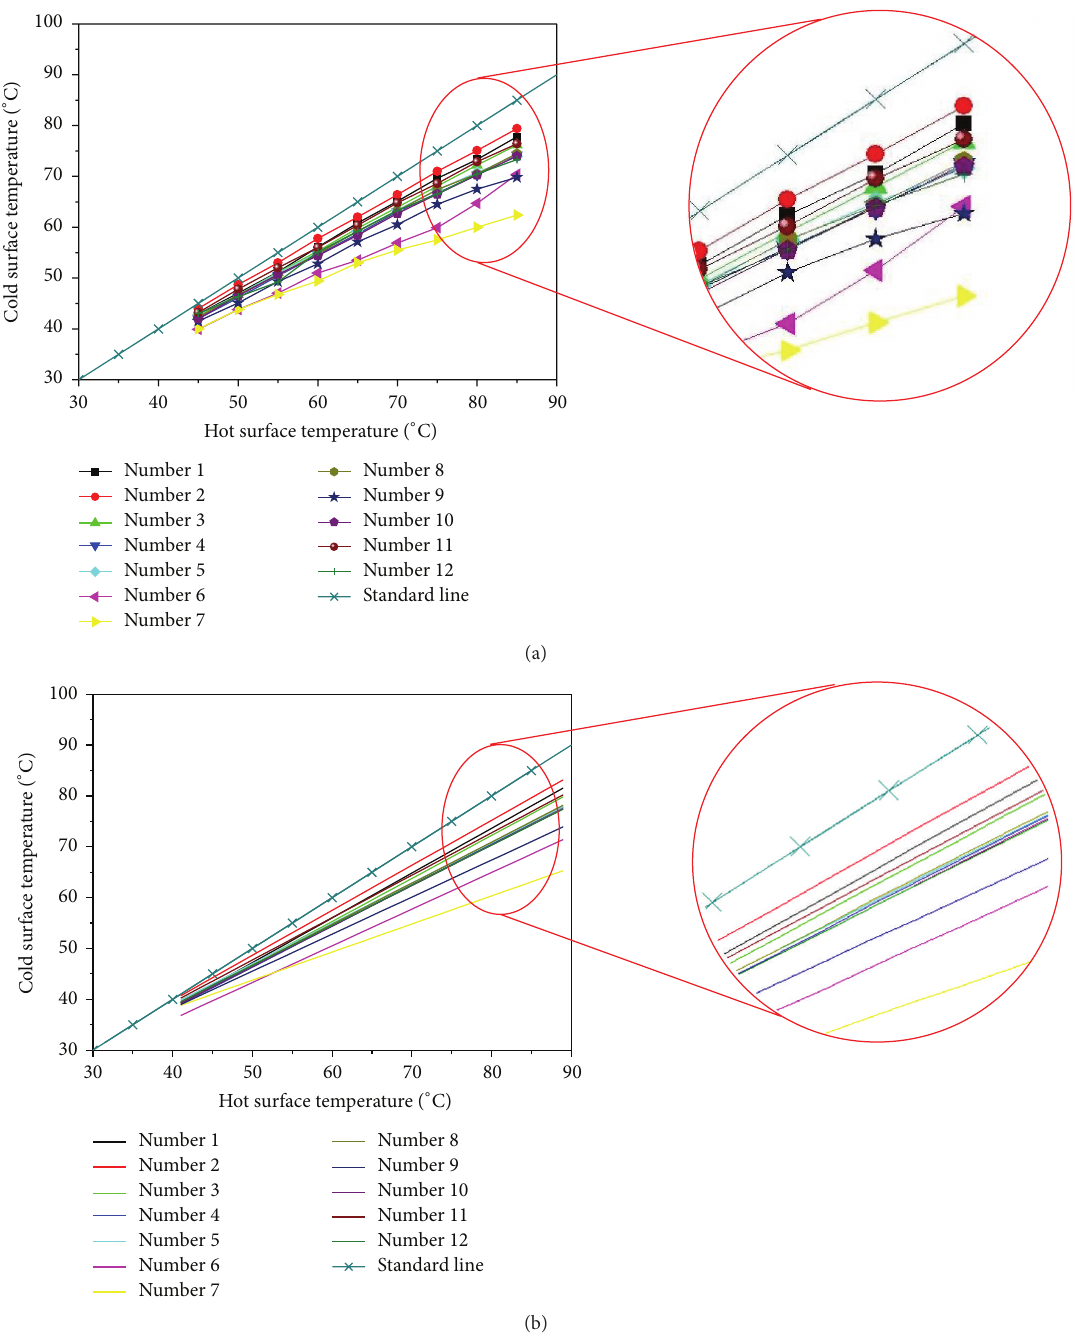
Figure 4: (a) Cold surface temperature as a function of hot surface temperature for the paper cups. (b) The fitting curve of each deviation curve in